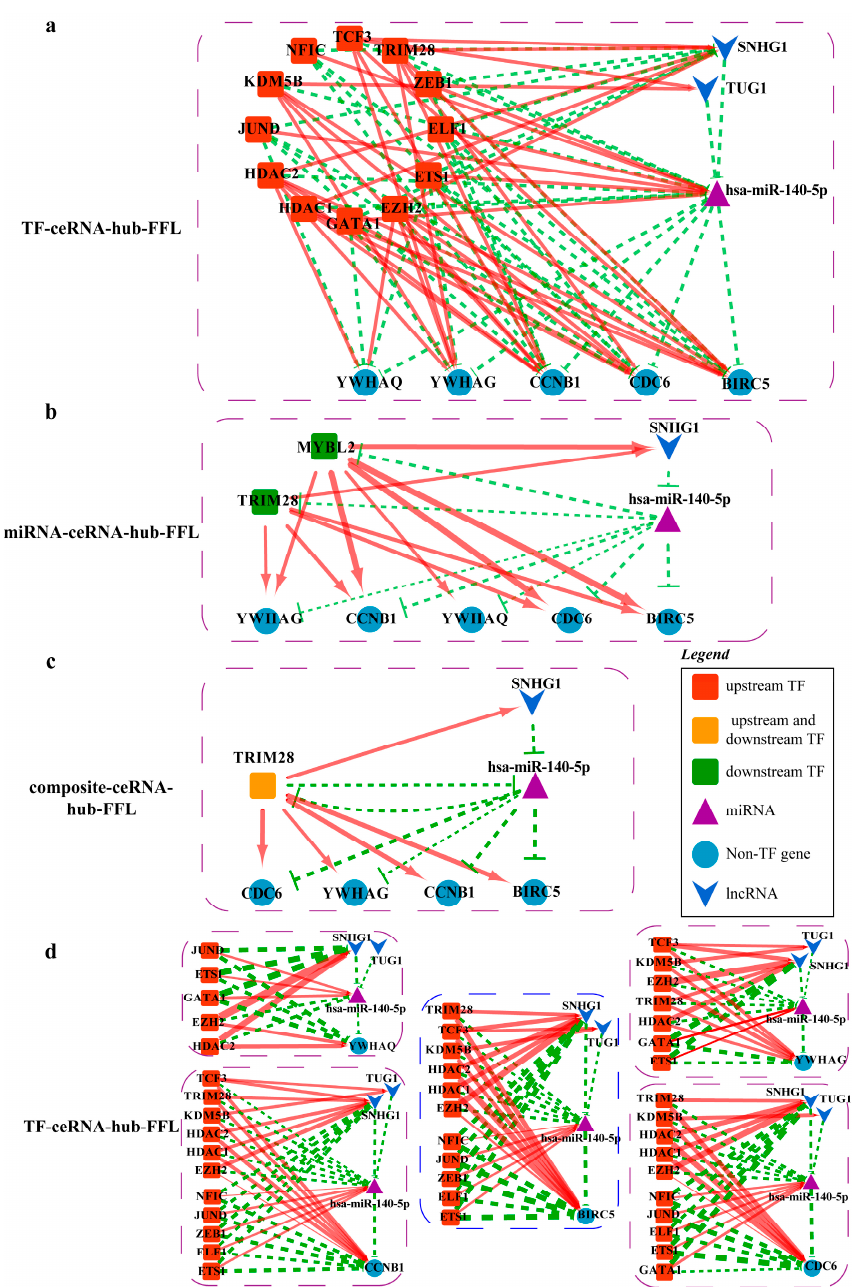
Figure 19. MiR-140-5p related ceRNA-hub-FFL subnetworks: ( a ) MiR-140-5p related I-FFL network; ( b ) MiR-140-5p related II-FFL network; ( c ) MiR-140-5p related III-FFL network; ( d ) Detail map of miR-140-5p related type I ceRNA-hub-FFL. Green dashed line indicates inhibition, while red indi- cates activation and line thickness indicates the strength of correlation.